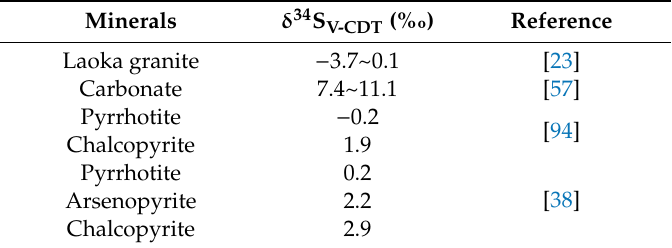
Table 8, the S isotopic compositions of di ff erent sulfide minerals (pyrrhotite, arsenopyrite, chalcopyrite) indicate that their δ 34 S values ( − 0.2% (cid:24) ~2.9% (cid:24) , [38,94]) fall within the range of the δ 34 S values for granite ( − 3.7% (cid:24) to 0.1% (cid:24) , [23]), which is obviously lower than that of the Gejiu Formation carbonate rock (7.14% (cid:24) to 11.1% (cid:24) , [57]), and interpreted to be of magmatic origin. All of the above data demonstrate that the Laoka granite provided the source material for tin mineralization. Table 8. Composition of sulfur isotope in the Xi’ao Cu-Sn polymetallic